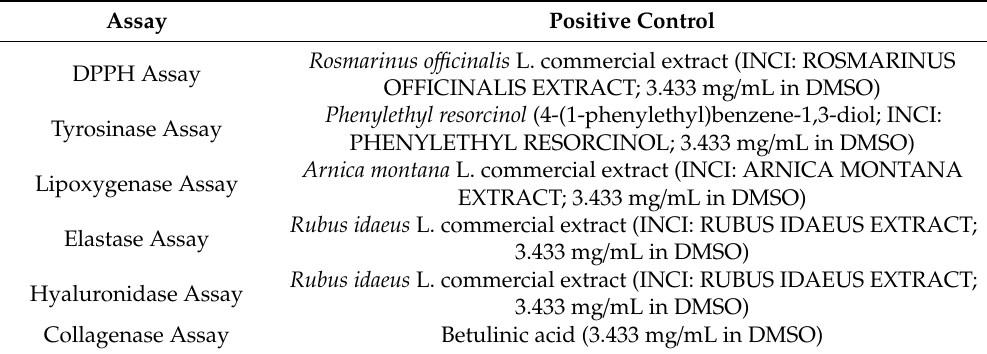
Table 1. Positive controls used in each bioassay